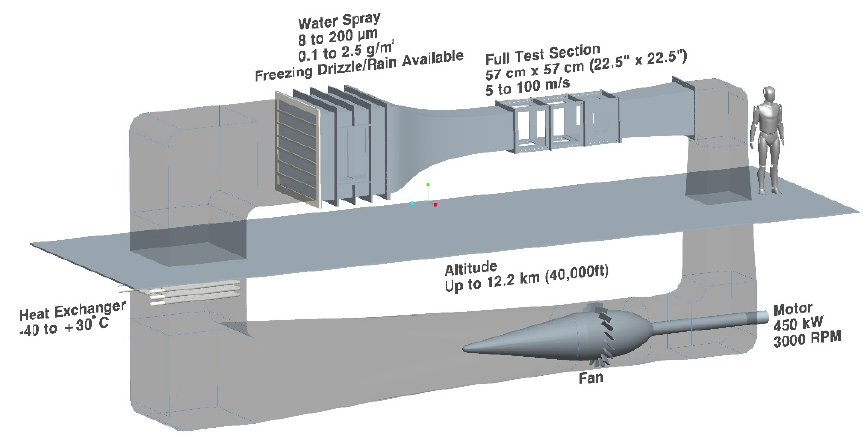
Figure 1. NRC − AIWT schematic diagram.